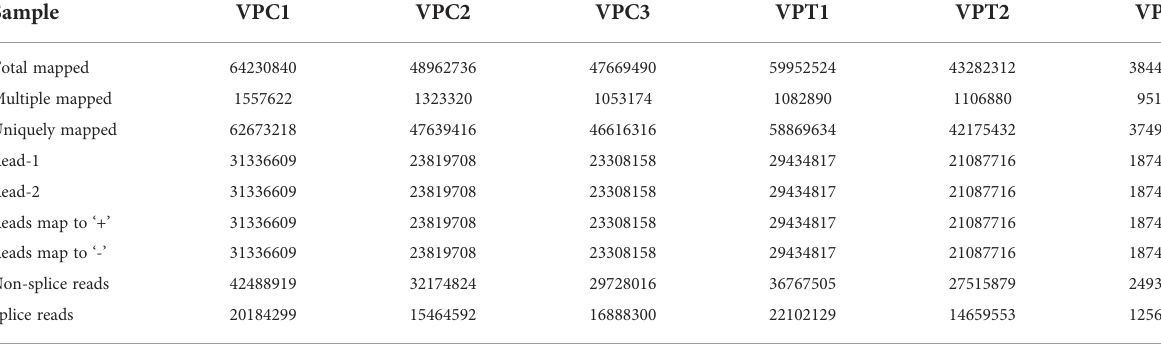
TABLE 1 Summary of clean reads mapped to the reference genome of tobacco cv.